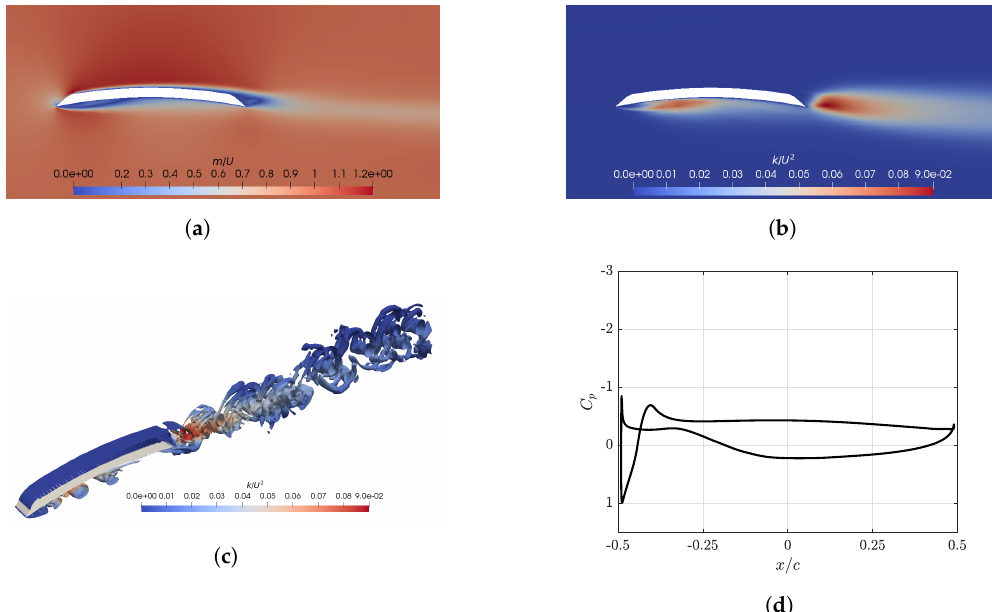
Figure 6. Flow behavior for Re = 10 4 and AoA = 0 ◦ . ( a ) Non-dimensional magnitude of mean velocity m / U ; ( b ) Non-dimensional resolved turbulence kinetic energy k / U 2 ; ( c ) Isosurface of the non-dimensional resolved second invariant of velocity gradient ˜ Q · c 2 / U 2 = 1 colored by the non-dimensional resolved turbulence kinetic energy k / U 2 ; ( d ) Pressure coefficient C p .